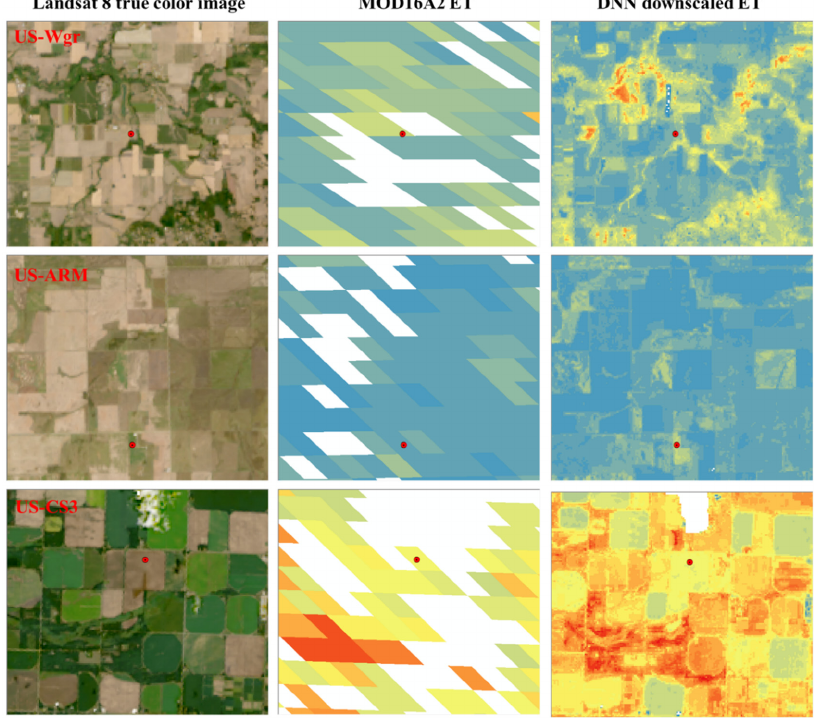
Figure 8. Landsat 8 true-color SR images (first column), MOD16A2 ET (second column) and DNN downscaled ET (third column) near three flux towers on the three Landsat acquisition dates from Figure 1.